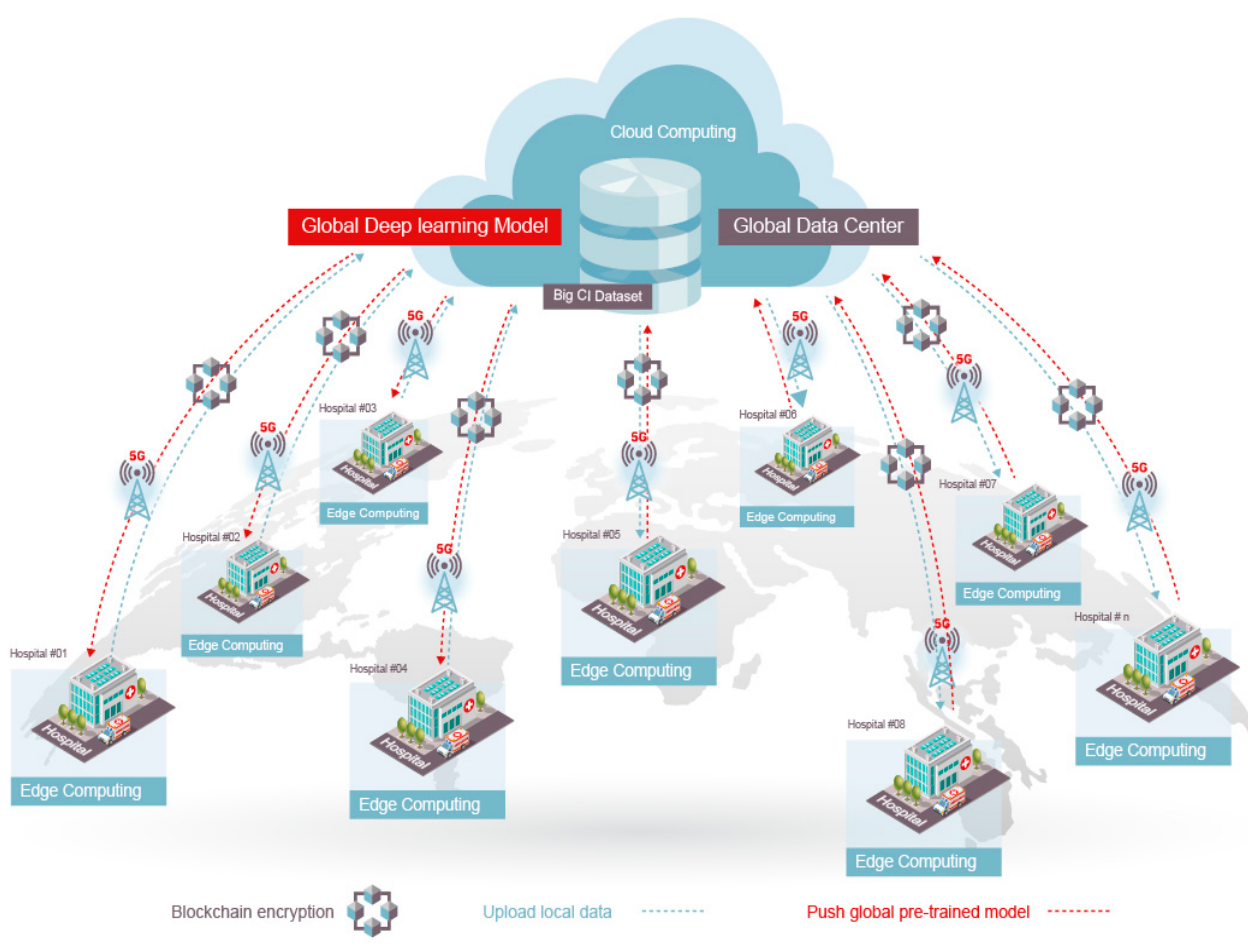
Figure 1. A conceptual design of the proposed framework.